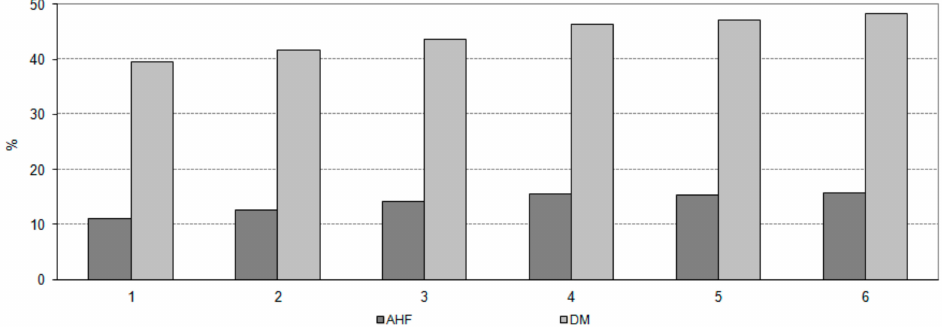
Figure 7. Errors of river recharge calculated with the AHF analytical model and estimated with the Darcy’s law model (DM) related to the values calculated by the SEEP2D model.